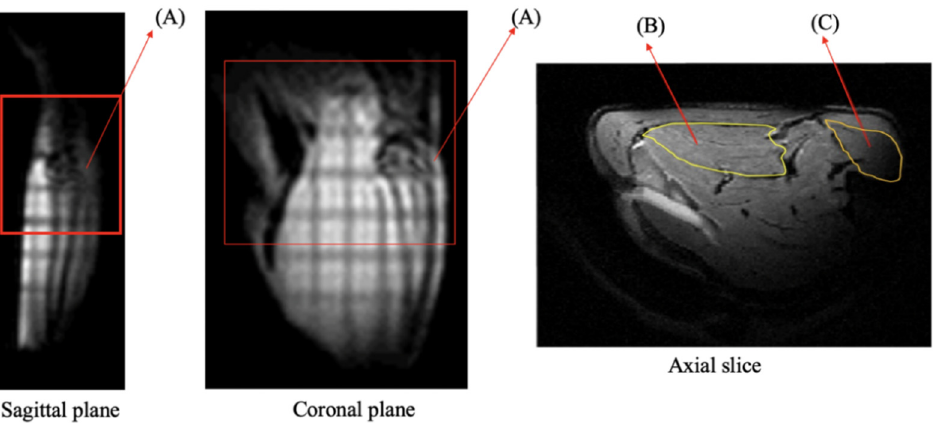
Figure 4. T2-weighted image scanning plan for the detection of the compartment region in the rats. The sagittal and coronal planes are the localizer views. A: Shows the knee joint. The red box indicates the range of the scanner’s field of view. The axial slice was localized from the sagittal and coronal planes. B: The locations correspond to the gastrocnemius muscle (GA), which is located at the posterior side of the leg. C: Tibialis anterior muscle (TA), which is located on the anterior side of the leg. The yellow mark indicates the border of the muscles.